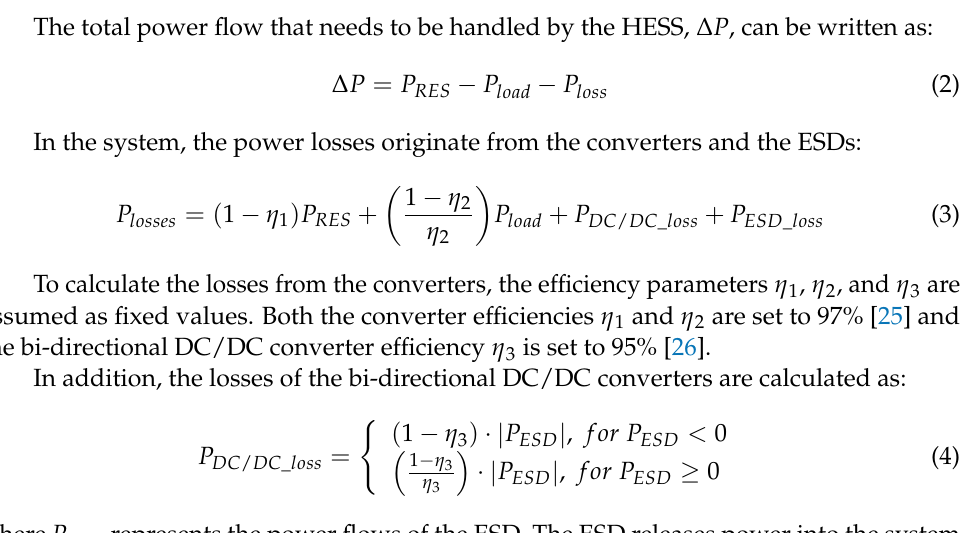
Figure 4. Power flows between the RES, the load, and the HESS. ( a ) Wind-powered household- prosumer system. ( b ) PV-powered household-prosumer system.